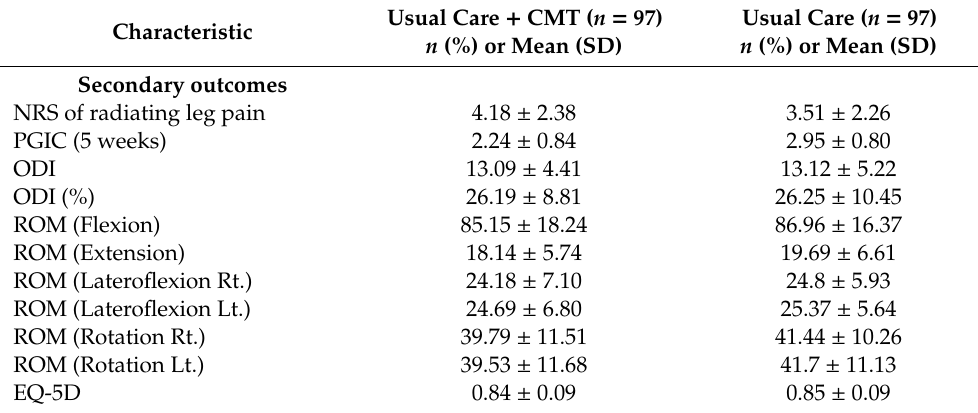
Figure 2. Consolidated Standards of Reporting Trials (CONSORT) 2010 flow diagram. CMT: Chuna manipulative therapy; UC: usual care.